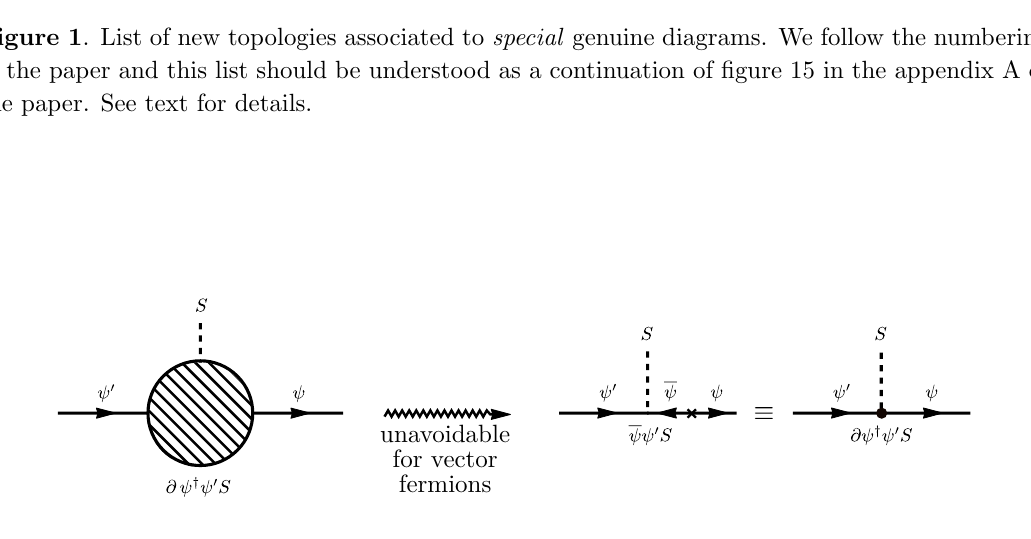
Figure 2 . Consider a loop induced coupling of the left-handed fermions and 0 to a scalar S as indicated on the left. Given the chirality of the fermions, the e(cid:11)ective coupling is @ y 0 S . If has a vector-like partner